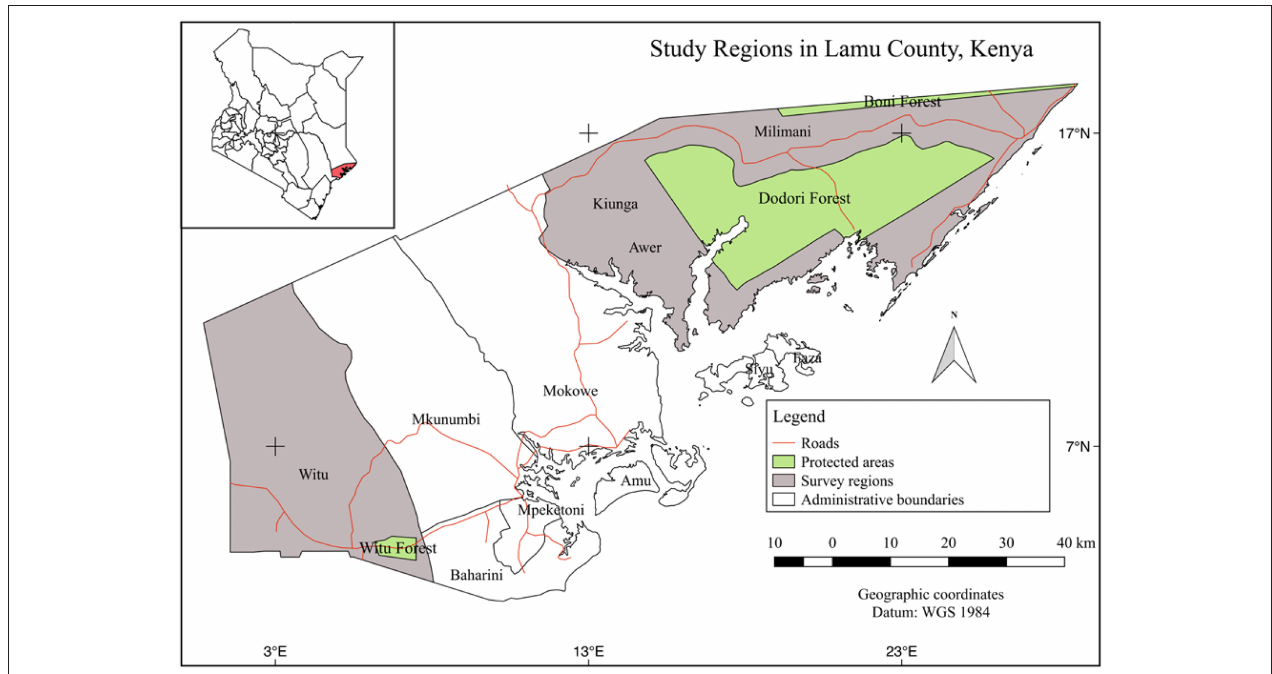
FIGURE 1 | Geographical context of IGAD’s honey value chain intervention project.